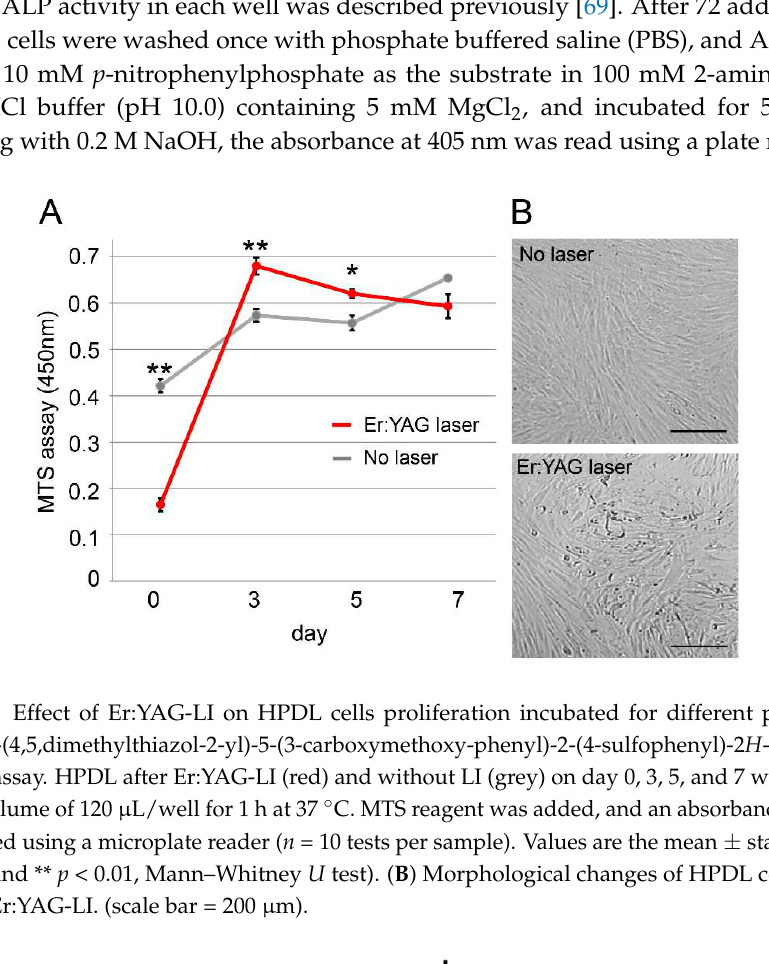
Figure A5. Isolation and detection of active forms of TGF-β, MMP2 and MMP11 in porcine dental pulp [33]. ( a ) Heparin-sepharose chromatogram of extracts from porcine dental pulp detected at 280 nm absorbance. Downward-pointing arrows represent the starting points of the step gradient with 0.05, 0.1, and 0.2 M NaCl. ( b ) ALP-inducing activity of HPDL cells with (+) or without (−) the addition of SB431542 to fractions P1–P4 isolated by chromatography. Recombinant human TGF-β1 with a carrier (0.3 ng/mL) (TGF-β1) was used as a positive control for the detection of ALP-inducing activity in HPDL cells. The data show the average value of six measurements. ( c ) A gelatin zymogram of fractions P1–P4 incubated without (left) or with (right) EDTA. ( d , e ) Western blots of fractions P1–P4 with specific antibodies against ( d ) MMP2 and ( e ) MMP11. Figure A6. In vitro activation of latent TGF-β1 by MMP2 or MMP11 [33]. Latent TGF-β1 was incubated with rhMMP2 or rhMMP11. ALP-inducing activity of HPDL cells exposed to ( a ) latent TGF-β1 only